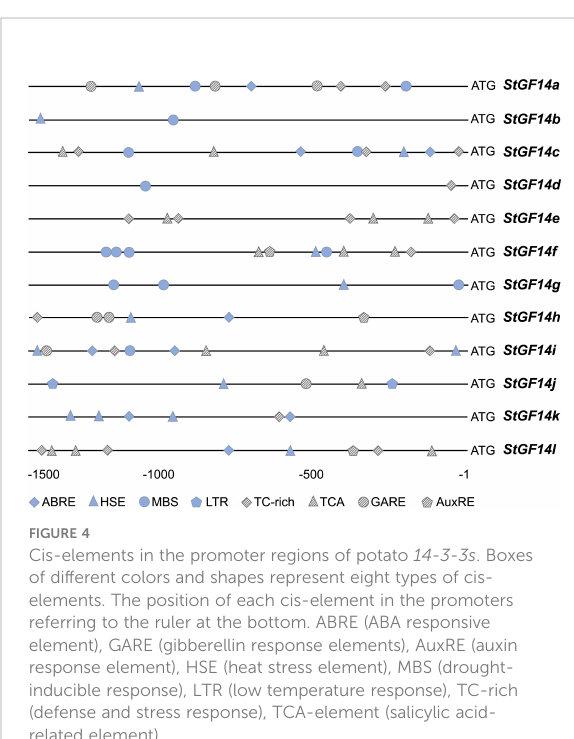
FIGURE 4 Cis-elements in the promoter regions of potato 14-3-3s . Boxes of different colors and shapes represent eight types of cis- elements. The position of each cis-element in the promoters referring to the ruler at the bottom. ABRE (ABA responsive element), GARE (gibberellin response elements), AuxRE (auxin response element), HSE (heat stress element), MBS (drought- inducible response), LTR (low temperature response), TC-rich (defense and stress response), TCA-element (salicylic acid- related element).